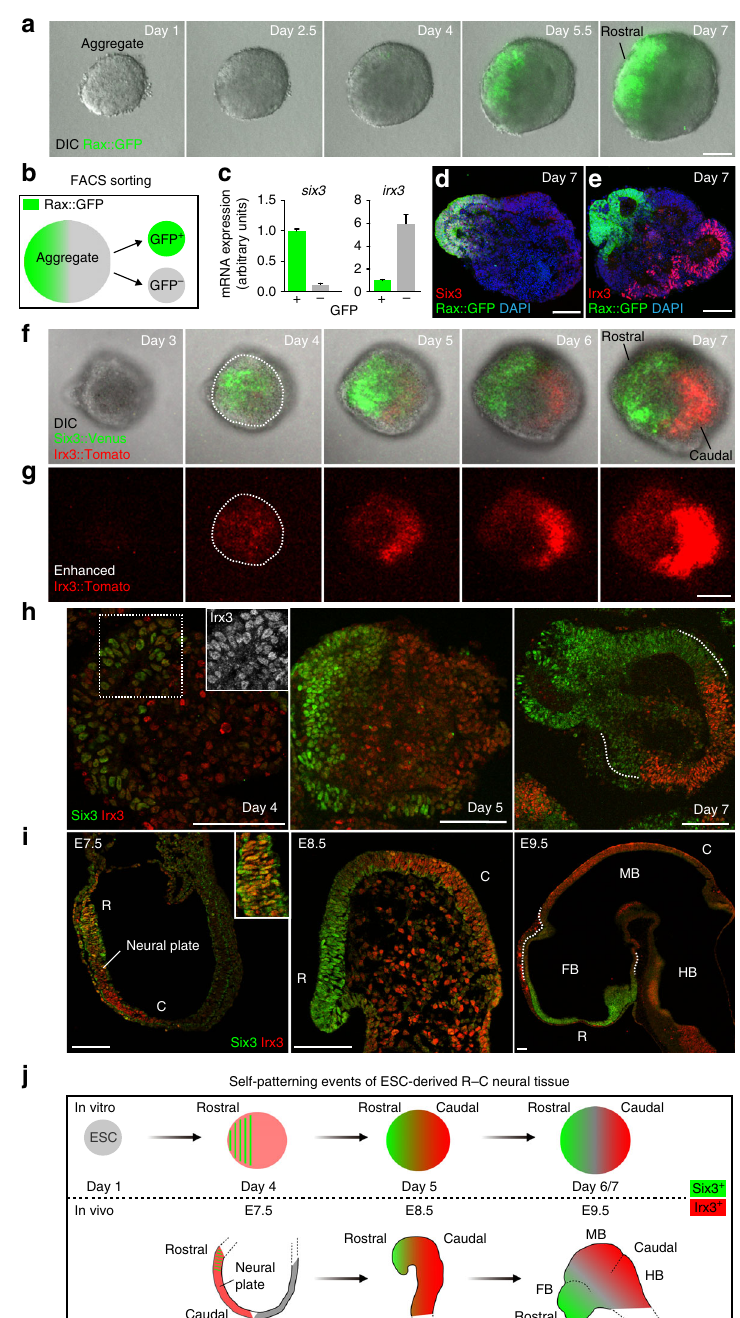
Fig. 1 Self-patterning of rostral-caudal neuroectoderm in 3-D ESC culture. a Montage of images taken from Supplementary Movie 1, showing merged images of differential interference contrast (DIC) and Rax::GFP expression in the SFEBq aggregates, and epithelial structure formation around day 4. b Diagram of cell sorting of day-7 aggregates via fl uorescence activated cell sorting (FACS) using the Rax::GFP ESC line. c Quanti fi cation of six3 and irx3 expression via RT-qPCR, following FACS sorting of GFP + and GFP − cells. Error bars indicate standard error of the mean (s.e.m) of each FACS-sorting experiment. Data represent mean ± s.e.m. d , e Immunohistochemistry was performed on cryosections of day-7 Rax::GFP aggregates using antibodies recognizing GFP, Six3 and Irx3. DAPI was used for counter staining. f Montage of images taken from Supplementary Movie 2, showing DIC, Six3::Venus and Irx3::Tomato expression. g Montage of images taken from Supplementary Movie 2, showing enhanced time-lapse images of Irx3::Tomato expression via ImageJ software to see a dim expression. Dotted lines in day-4 images show outline of aggregates ( f , g ). h , i Immunostaining of cryosectioned day-4, -5 and -7 aggregates ( h ); E7.5, 8.5 and 9.5 embryos ( i ), showing Six3 and Irx3 staining. R, rostral; C, caudal; E. embryonic day. A dotted square in day-4 aggregate ( h ) corresponds to a single channel image of Irx3 (white) shown via an inset. Dotted lines in day-7 aggregate ( h ) and E9.5 embryo ( i ) show the regions of weak Six3 expression. j Schematic diagram of in vitro and in vivo rostral-caudal NE formation. ESC, embryonic stem cell; FB, forebrain; MB, midbrain; HB, hindbrain. Scale bars, 100 µ m ( a , d , e , g , h , i ). These images were one of n = 3 experiments ( a , d – i